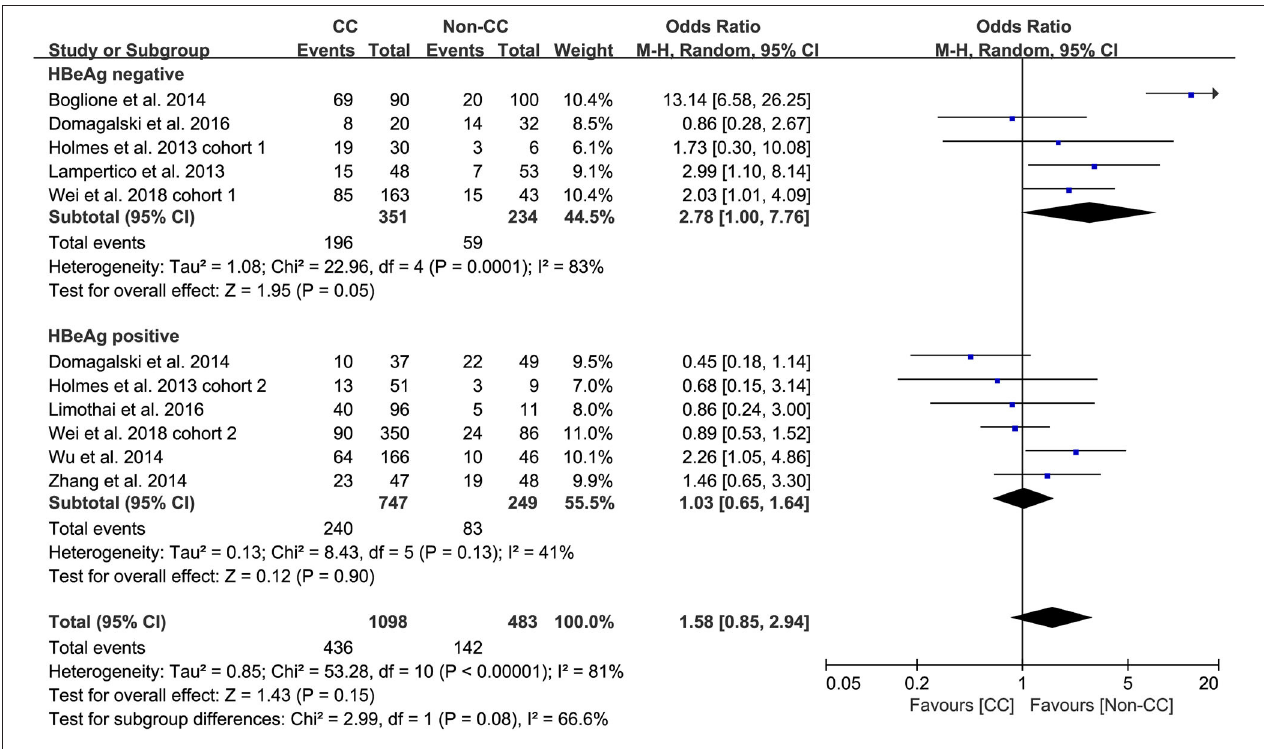
FIGURE 4 | Subgroup analysis of rs12979860, stratified by HBeAg.